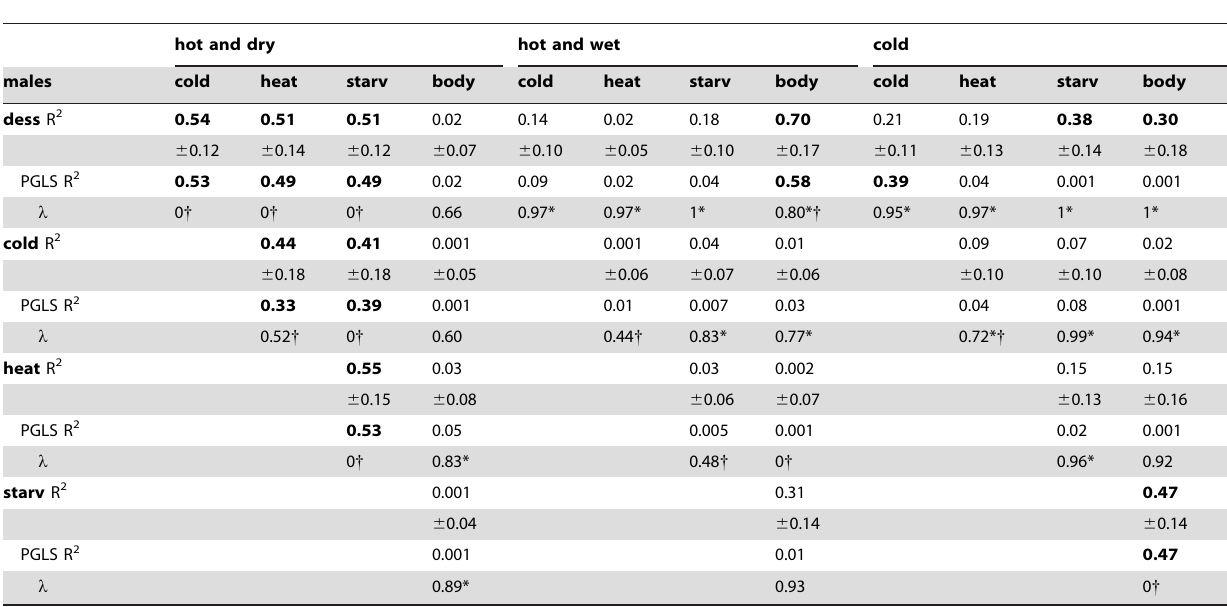
Table 4. Correlated responses for resistance to desiccation (dess), cold, heat, and starvation resistance (starv), and body size (body) for male Drosophila , divided into three environments (hot and dry, hot and wet, cold).